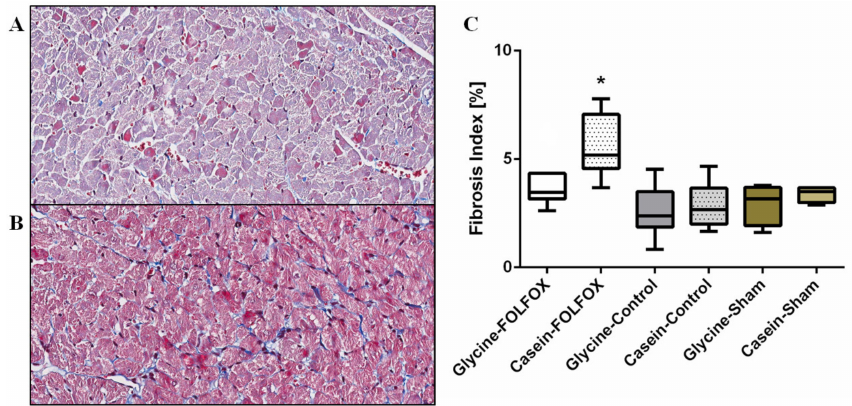
Figure 5. Fibrosis index measured by chromotrope aniline blue staining. Representative pictures at 100 × magnification of chromotrope aniline blue stain for fibrous tissue in the myocardium of animals treated with FOLFOX and glycine ( A ) and FOLFOX alone ( B ). The amount of fibrosis between the study groups was di ff erent ( C ). * The fibrosis index in the group treated with FOLFOX alone was significantly higher compared to that of all other study groups, p < 0.05.